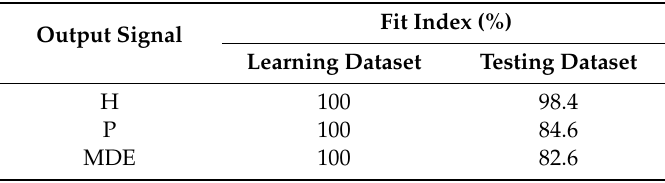
Table 3. Fit index for the ANN with a 2-6-3 structure.